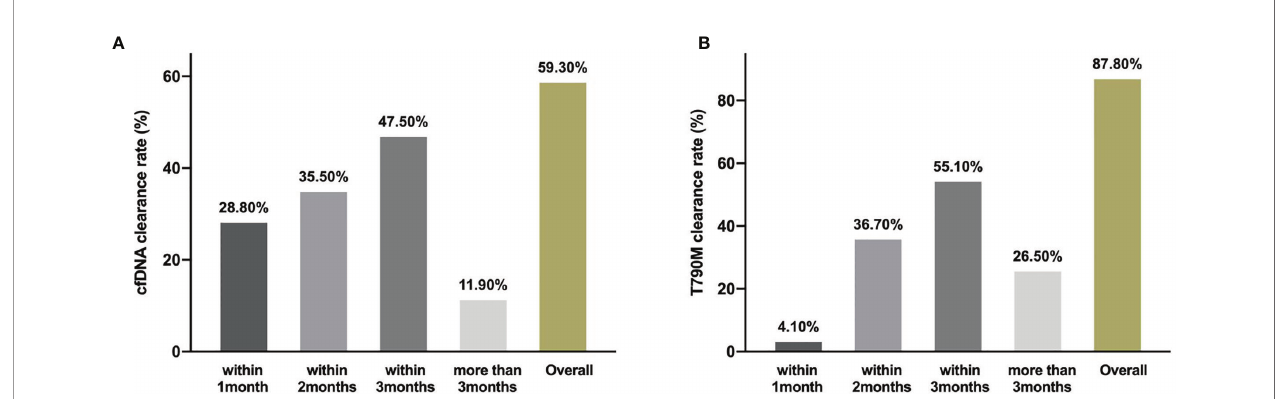
FIGURE 1 | Patient enrollment.